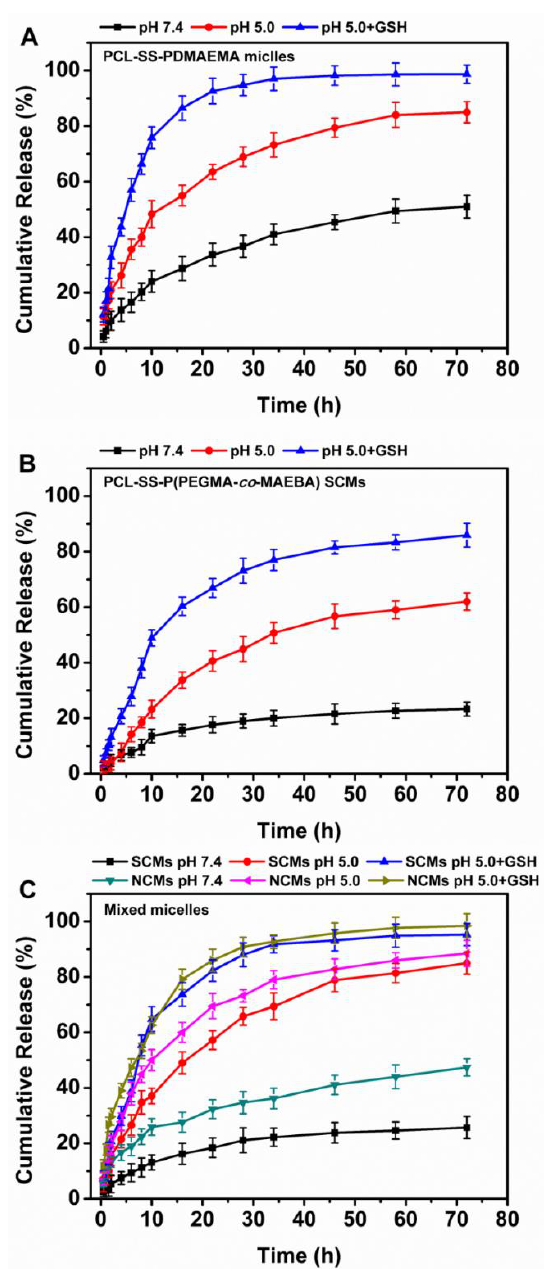
Figure 10. In vitro drug release profiles of PCL-SS-PDMAEMA micelles ( A ), PCL-SS-P(PEGMA- co -MAEBA) cross-linked micelles ( B ) and reversible cross-linked mixed micelles ( C ).